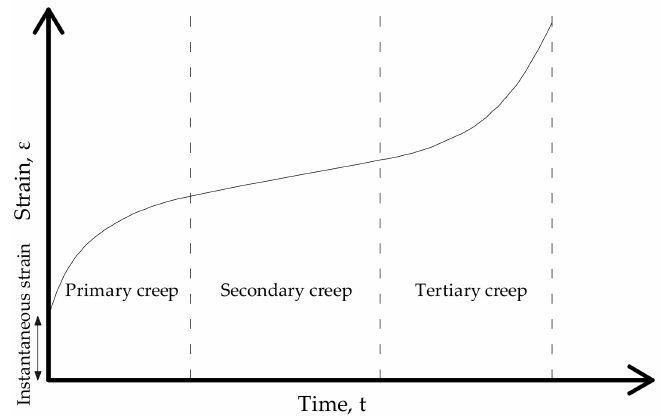
Figure 1. Schematic graph illustrating the three classical stages of creep for